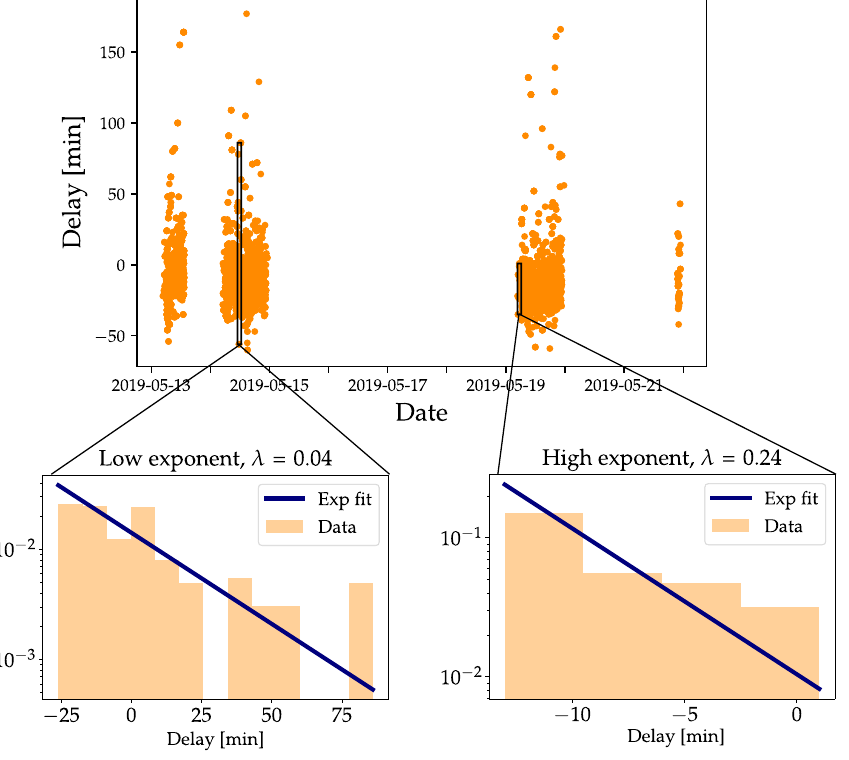
Figure 7. We analyse the full time series of plane delays and extract a time window during which we observe locally exponential distributions. These local distributions can decay slowly or fast, i.e. the rate (cid:31) is